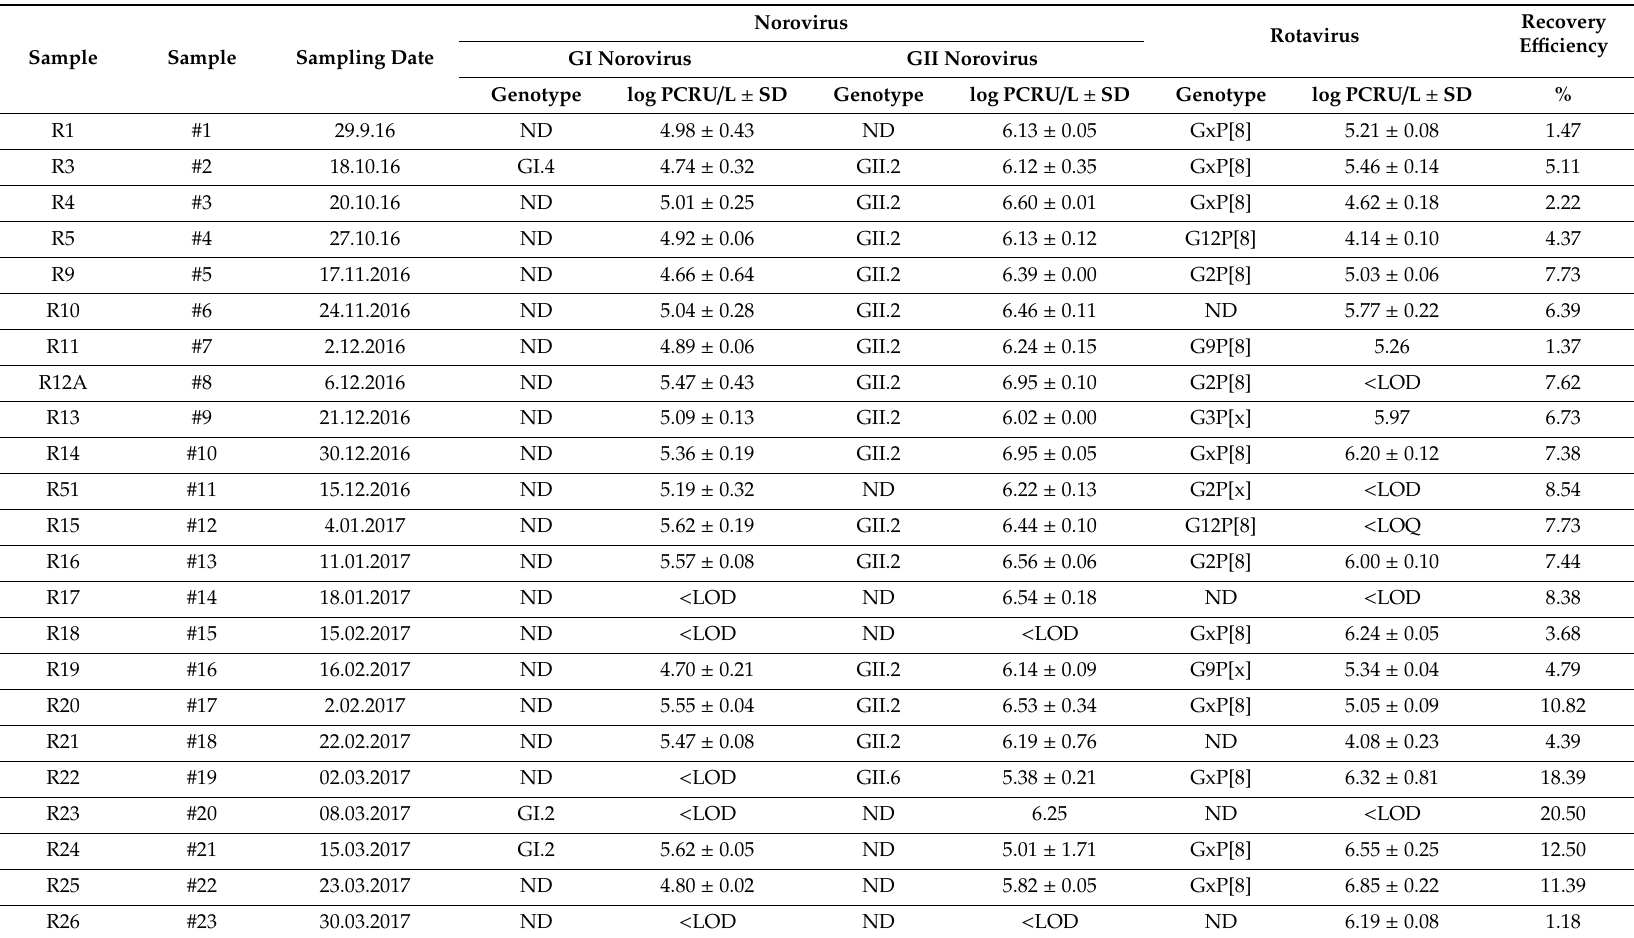
Table 2. Prevalence, viral loads (log 10 PCRU / L) and genotypes of norovirus GI, norovirus GII, and